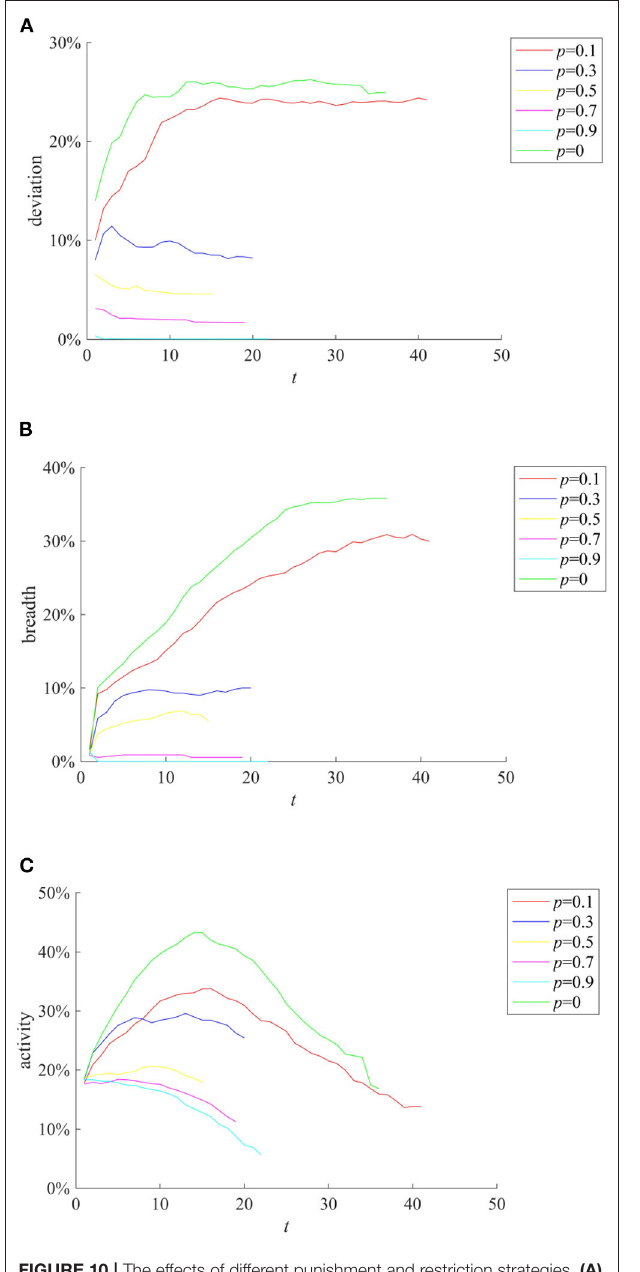
FIGURE 10 | The effects of different punishment and restriction strategies. (A) Entire network information content deviation. (B) Rumor diffusion range. (C) Network activity.